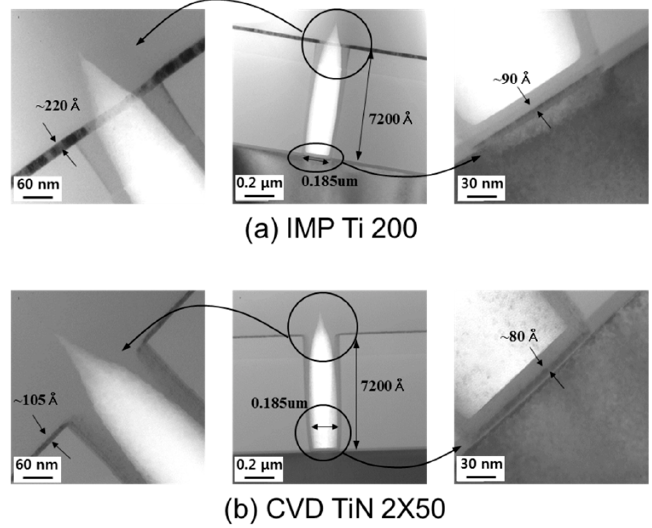
Figure 1. TEM image of ionized metal plasma (IMP) Ti and chemical vapor deposition (CVD) TiN at an aspect ratio of 3.89: 1. ( a ) IMP Ti 200. ( b ) CVD TiN 2 × 50 (unit: Å).